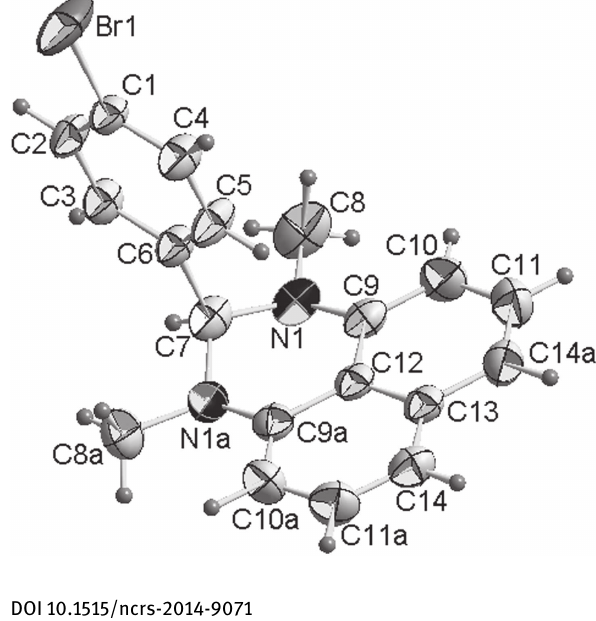
Table 1: Data collection and handling.